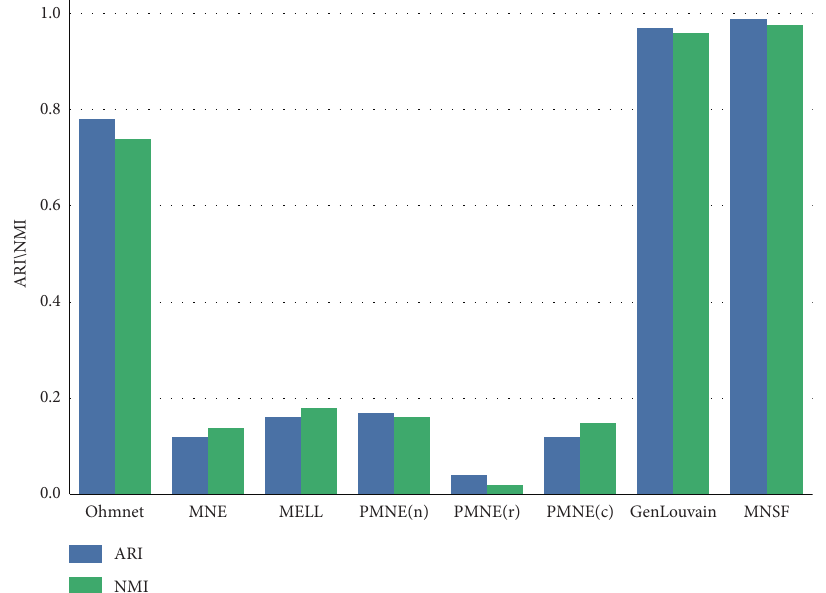
Figure 8: The ARI and NMI score performance of our model and baselines on the CKM multiplex network